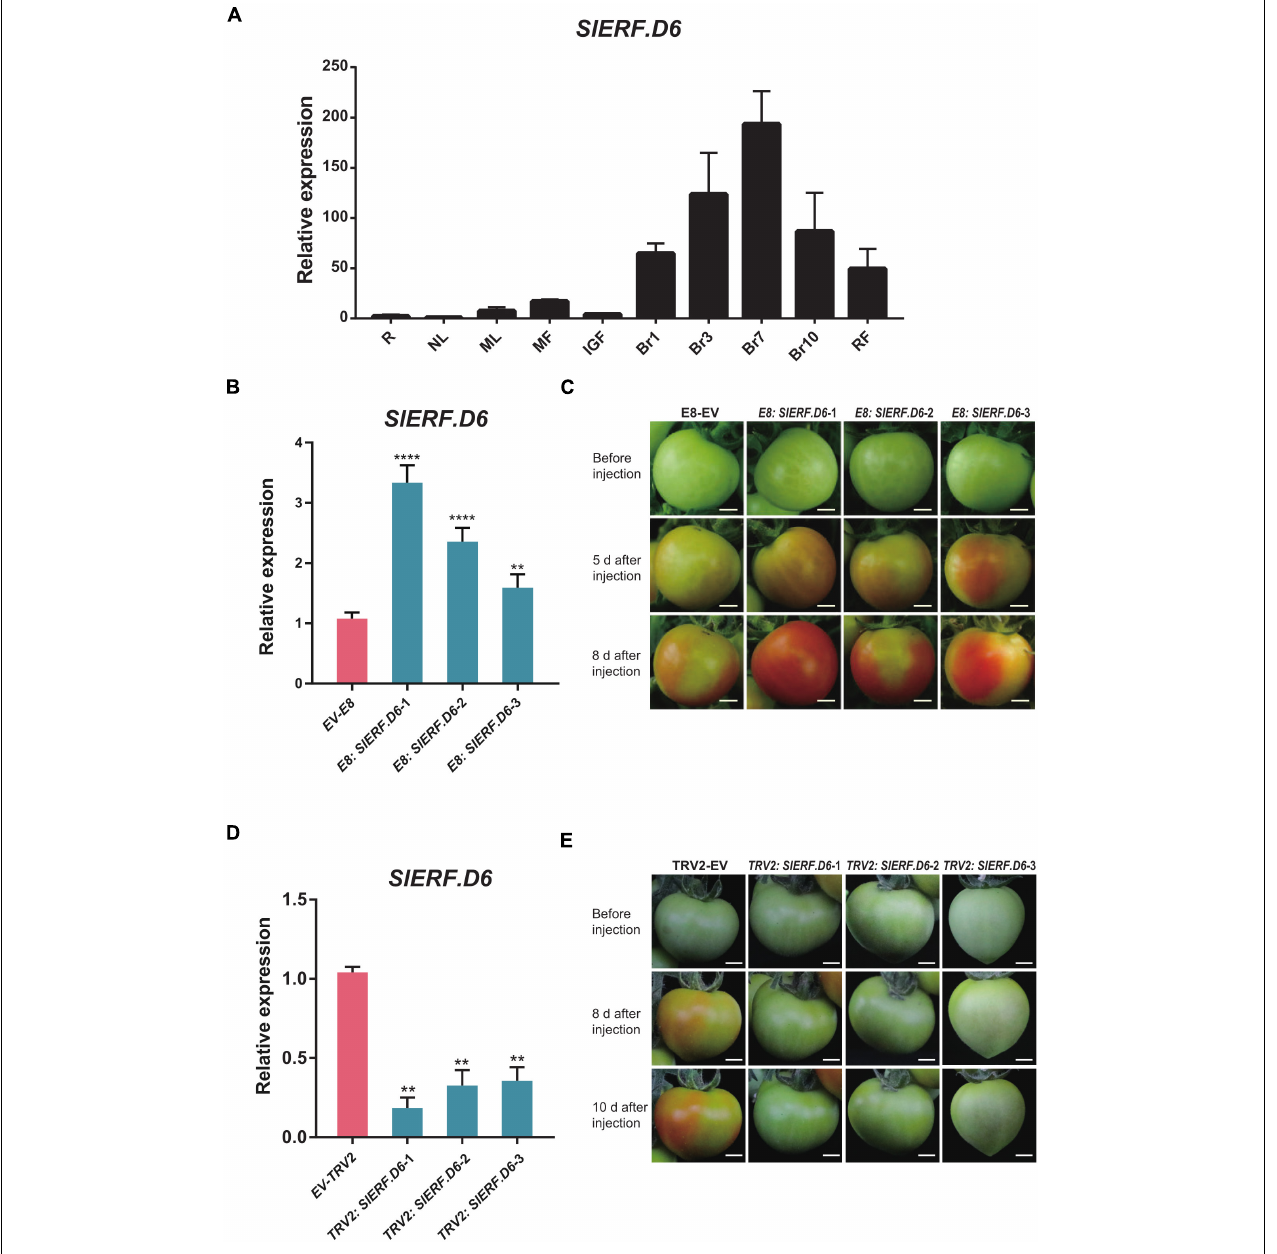
FIGURE 4 | The overexpression of SlERF.D6 can promote the fruit ripening. (A) The expression level of SlERF.D6 in different tissues and fruits in different periods by quantitative real-time PCR (qRT-PCR). The X -axis refers to the different tissues of tomato and the Y -axis is the relative expression. R, root; NL, new leaf; ML, mature leaf; MF, mature flower; IGF, immature green fruit; RF, red fruit; Br1, 1 day post breaker; Br3, 3 days post breaker; Br7, 7 days post breaker; Br10, 10 days post breaker; RF, red fruit. (B) Expression level of SlERF.D6 in E8: SlERF.D6 lines fruit. X -axis represents different lines. The empty vector (EV-E8) serves as control. (C) Phenotypes of E8: SlERF.D6 lines fruit after injection. Bars, 0.5 cm. (D) Expression level of SlERF.D6 in TRV2: SlERF.D6 lines fruit. X -axis represents different lines. The empty vector (EV-TRV2) serves as control. (E) Phenotypes of TRV2: SlERF.D6 lines fruit after injection. All the above error bars represent the SD ( n = 3) (** p < 0.01, **** p < 0.0001; Student’s t